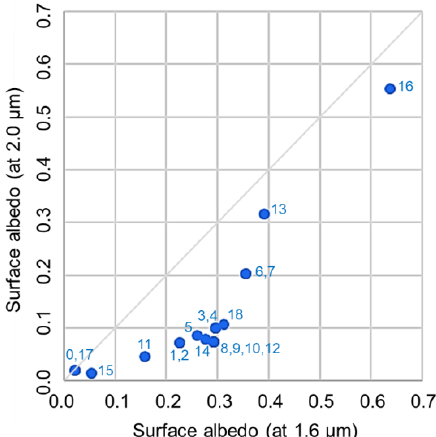
Figure 12. Surface albedo at CO 2 bands (1.6 μm and 2.0 μm) for each land cover type : 0, water; 1,